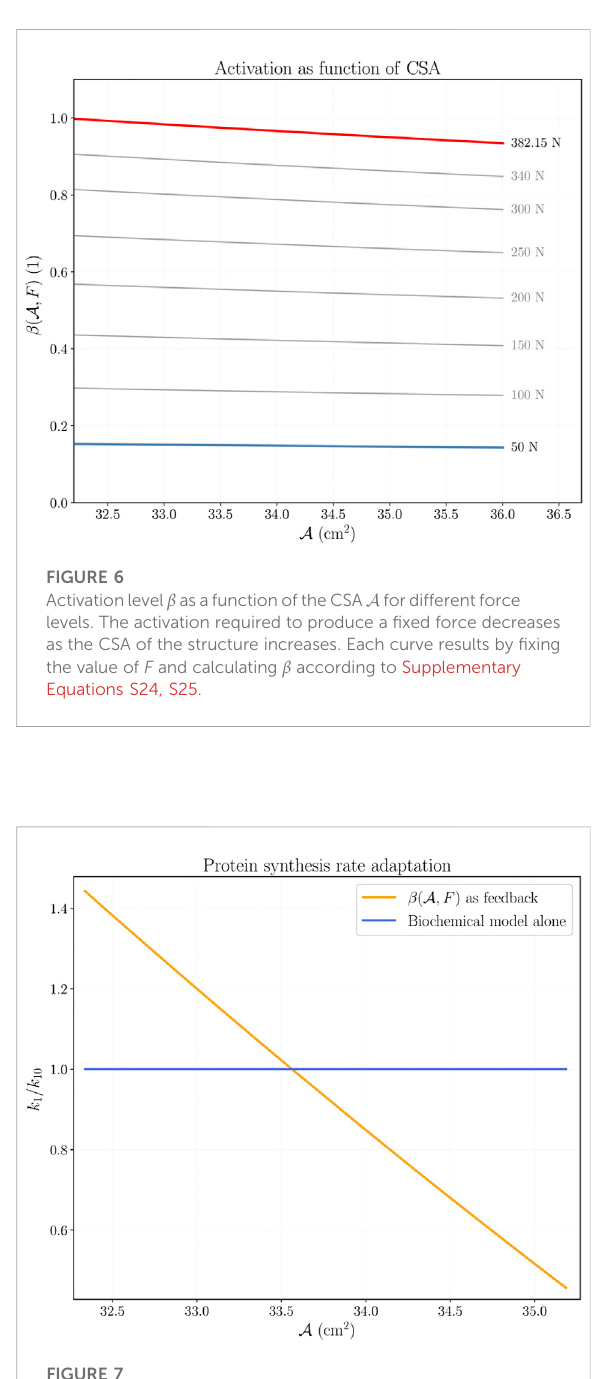
FIGURE 7 Protein synthesis rate k 1 given by Eq. 15, at parameters d 1